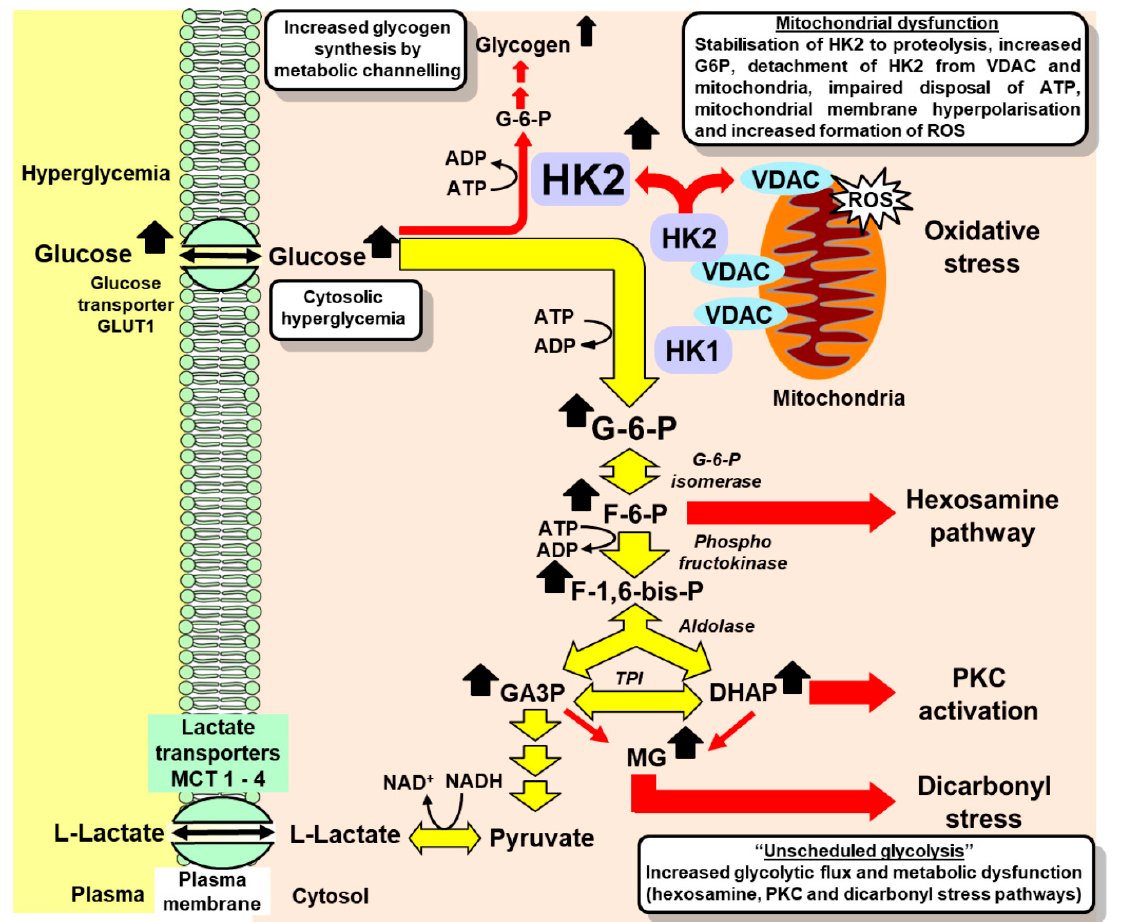
Figure 1. Glycolytic overload and unscheduled glycolysis in hyperglycemia. Key: red arrows—dysfunctional metabolism in unscheduled glycolysis. Metabolic intermediates in glycolysis from GA3P to pyruvate have been omitted for clarity. Abbreviations: DHAP, dihydroxyacetonephosphate; F-6-P, fructose-6-phosphate; F-1,6-bis-P, fructose-1,6-bisphosphate; G-6-P, glucose-6-phosphate; GA3P, glyceraldehyde-3-phosphate; HK1, hexokinase-1; HK2, hexokinase-2; MCT 1–4, monocarboxylate transporters 1–4; MG, methylglyoxal; ROS, reactive oxygen species; VDAC, voltage-dependent anion channel.